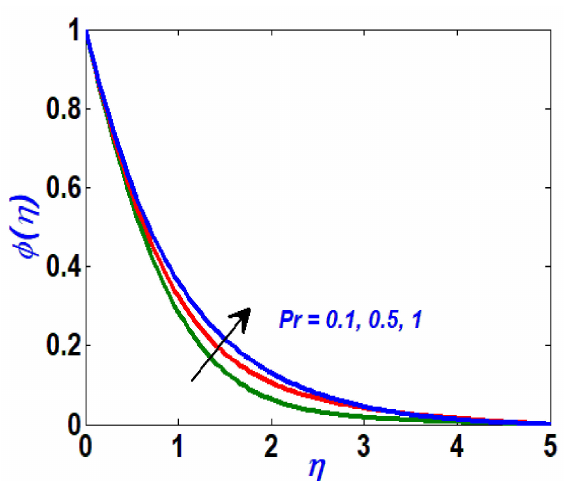
Figure 12. Concentration profile with variation in Pr .